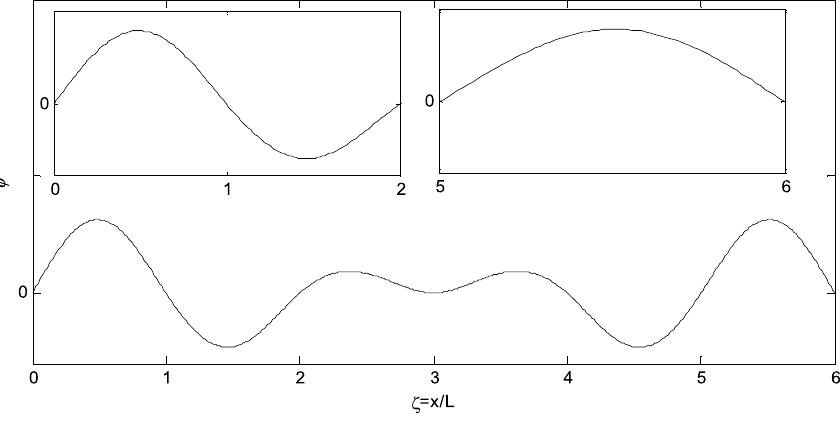
Fig. 9. Second mode shape of the six-span